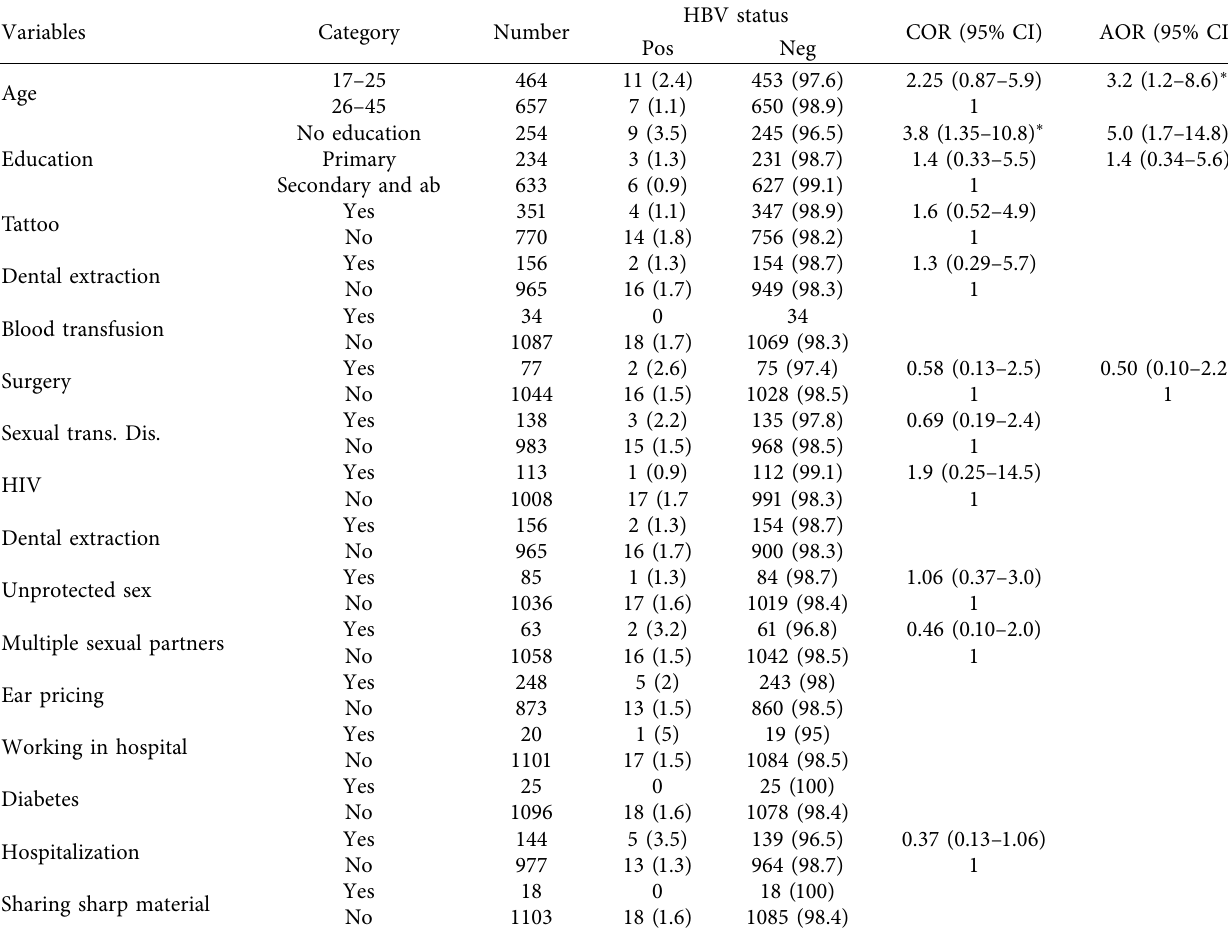
Table 5: Bivariate and multivariable analysis of factors associated with HCV infection among pregnant women in the Amhara national regional state in three tertiary hospitals from May 1, 2018, to September 30, 2019.